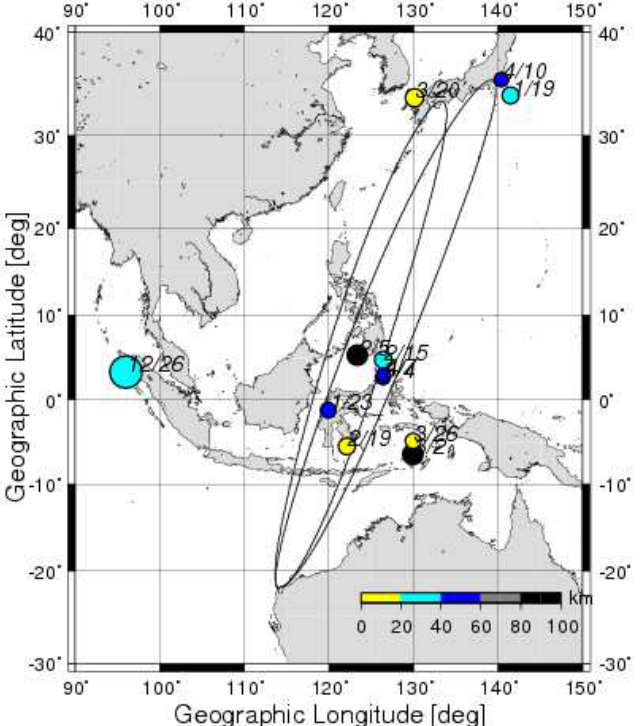
Figure 5. Propagation paths from the transmitter, NWC (in Australia) to the two receiving sites (Kochi and Chofu). The fifth Fresnel zone for each propagation path is indicated. The earthquakes with magnitude greater than 6.0 within and just close to the VLF sensitive zone during the years of 2004 and 2005 are all indicated. The center of each circle corresponds to the earthquake epicenter, and the size of the circle indicates the earthquake magnitude. The color of earthquakes during the period of November, 2004 to May, 2005 indicates the earthquake depth. The date of the earthquake is indicated beside the circle (i.e. 4/10 means April 10). The Sumatra earthquake is far away from the great-circle paths, but it is indicated